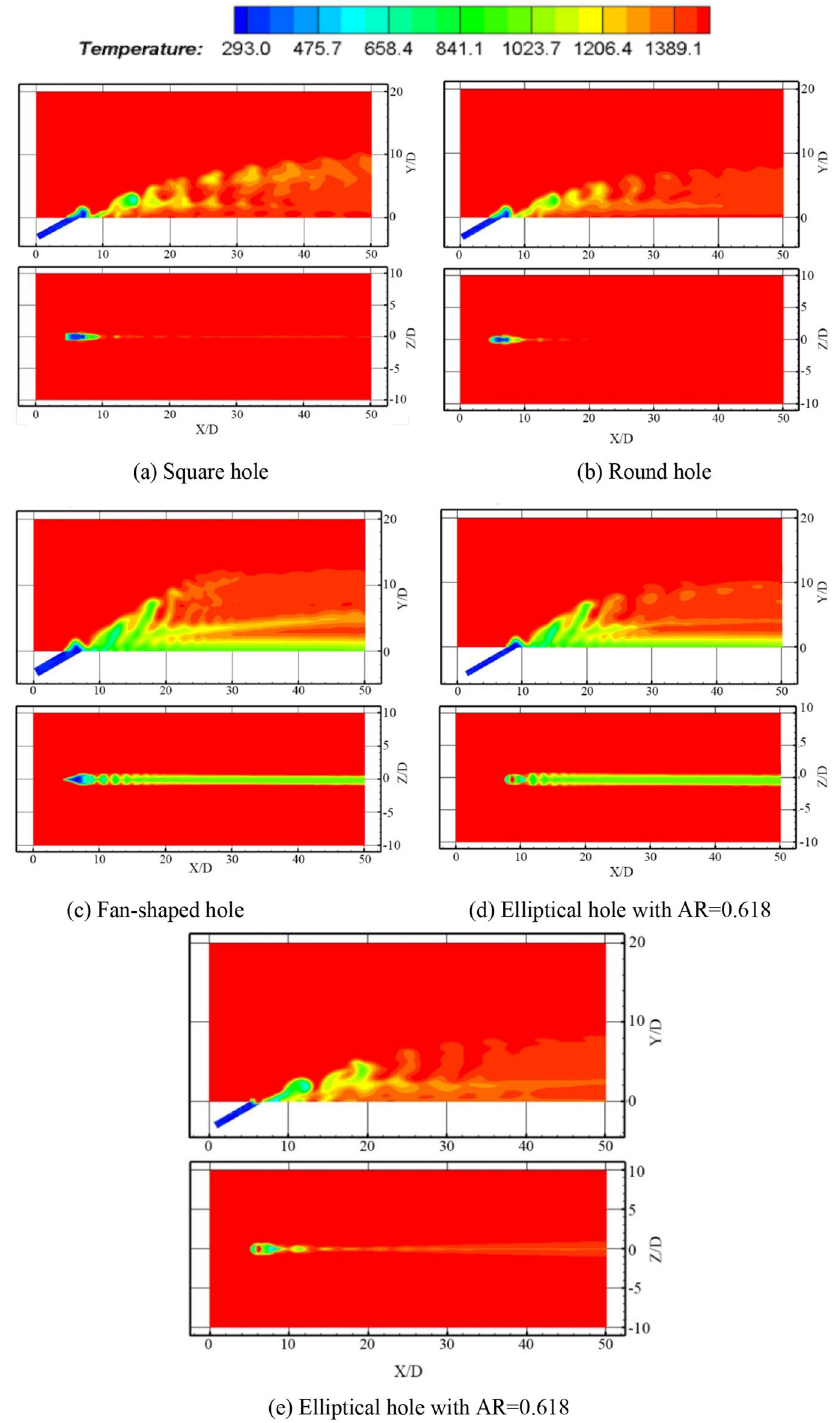
Figure 5. Temperature contours and comparison of the average film cooling effectiveness of synthetic coolants with different apertures